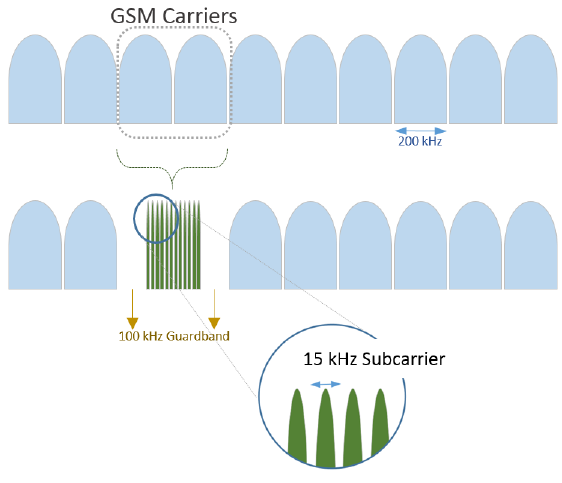
Figure 17. NB-IoT operation bands.